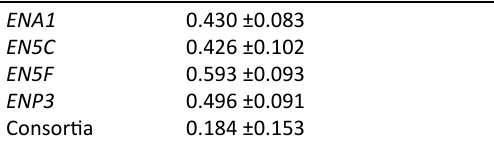
Mean and SD of OD are value of three